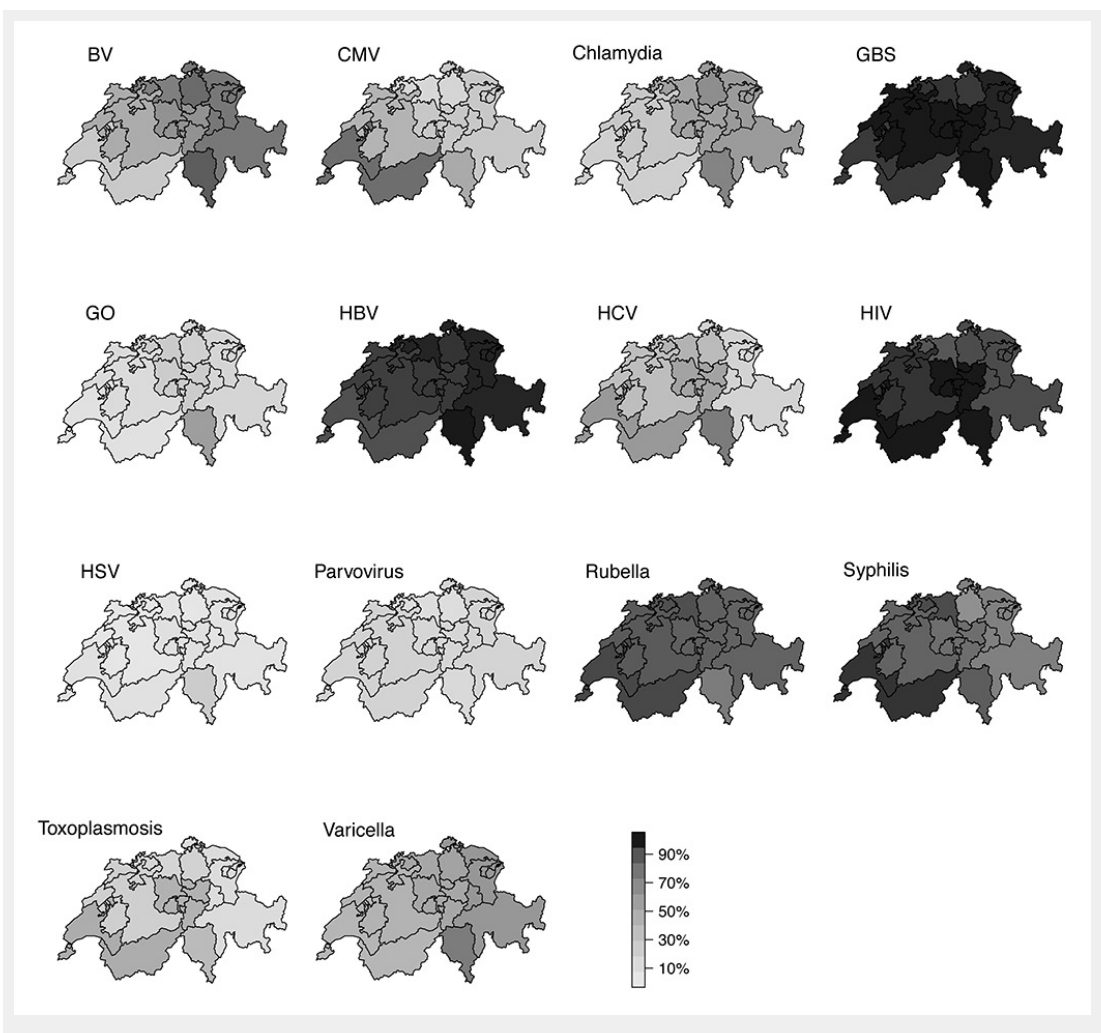
Figure 2 Percentage of participants reporting testing all pregnant women for the indicated disease, by region. BV = bacterial vaginosis; CMV = cytomegalovirus; GBS = group B streptococcus; GO = gonorrhoea; HBV = hepatitis B virus; HCV = hepatitis C virus; HIV = human immunodeficiency virus; HSV = herpes simplex